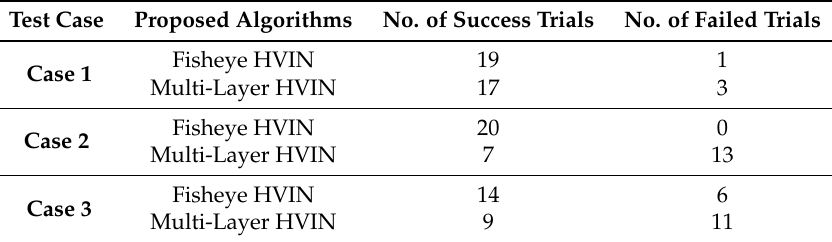
Table 2. Success ratio of “goal